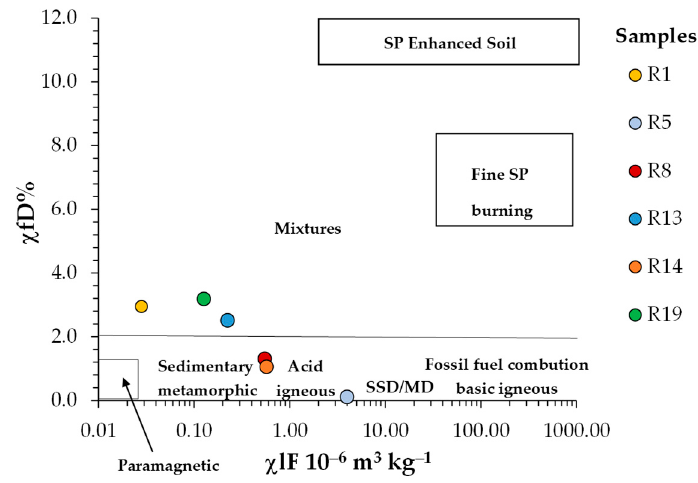
Figure 10. Mass magnetic susceptibility map of the mining area (magnetic susceptibility data inter- polation made by inverse distance weighting in the ArcGIS PRO software, ESRI).